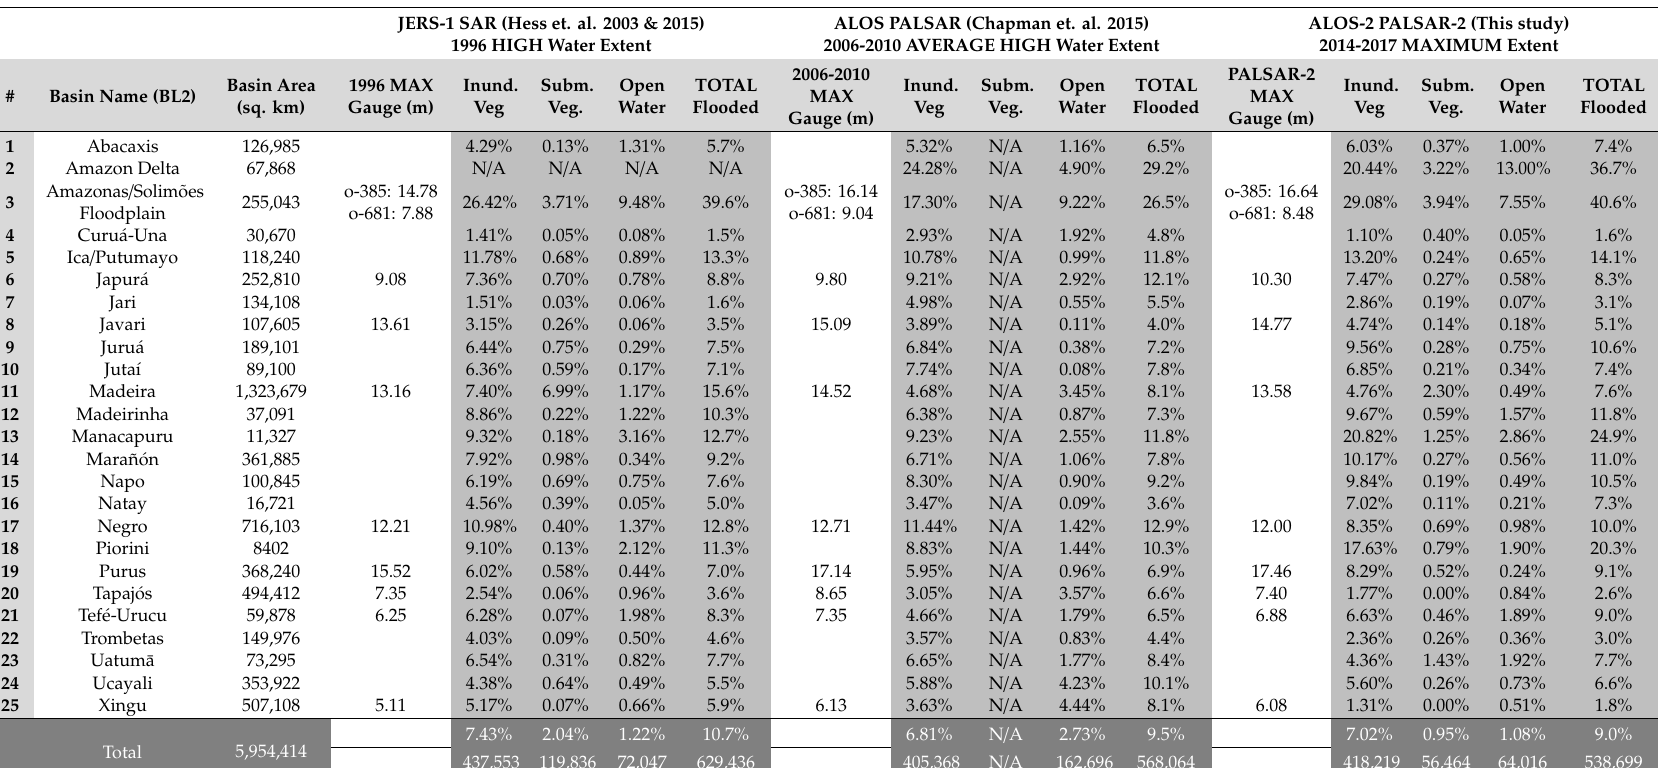
Table 4. Comparison of Amazon Basin high water / maximum inundation maps 1996–2017 by Hess et al. [8,9], Chapman et al. [11] and this